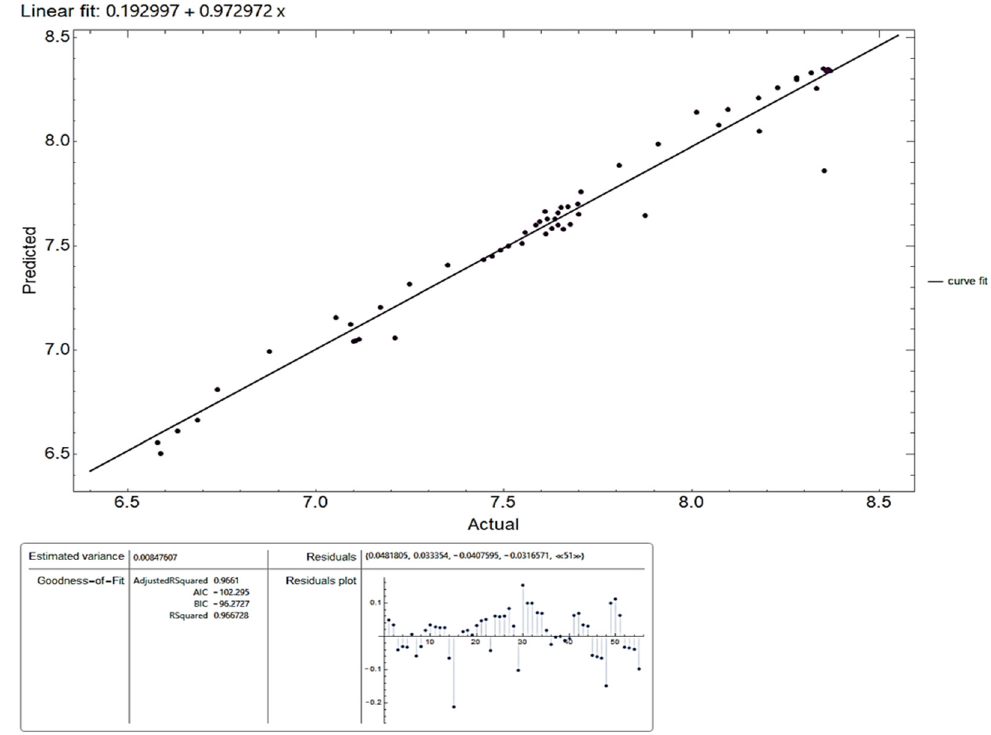
Figure 6. Predicted values of daily cash balances in the 2019 federal budget TSA against the values after the eighth iteration based on the DW [8] transformation (R2~0.967), in trillion rubles. Source: authors’ calculations.